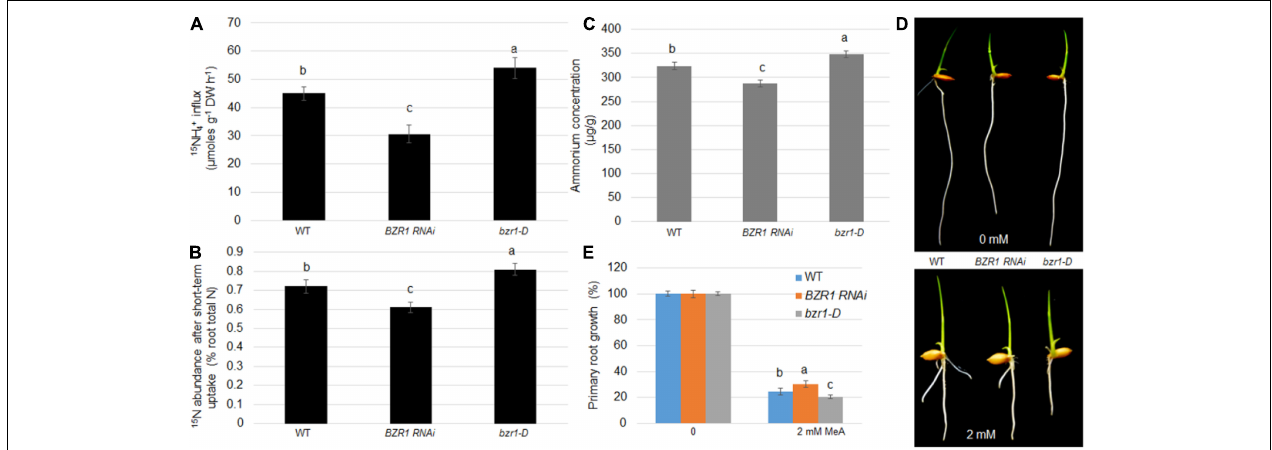
FIGURE 4 | BZR1 effects on NH 4 + uptake in plants. (A) The wild-type, BZR1 RNAi and BZR1 constitutively active bzr1-D plants were hydro-cultured in deionized water for 2 weeks, and then grown in a nitrogen-free nutrient solution for 3 days. After exposure to 200 µ M 15 N-labeled NH 4 + , the absorption of ammonium by rice roots was measured. Bars represent means ± SD ( n = 6). (B) The wild-type, BZR1 RNAi, and bzr1-D plants were hydro-cultured in deionized water for 2 weeks, and then grown in a nitrogen-free nutrient solution for 3 days. After exposure to nutrient solution containing 200 µ M 15 N-labeled NH 4 + for 6 min, the absorption of ammonium by rice roots and the 15 NH 4 + abundance in relation to the total 15 N in roots was measured. Bars represent means ± SD ( n = 6). (C) Intracellular NH 4 levels of wild-type, BZR1, and bzr1-D grown for 3 days in 0.5 × MS were detected in plant roots. Data represent means ± SE ( n = 3). (D) Under different conditions with 0 or 2 mM MeA, wild-type, BZR1 RNAi , and bzr1-D were grown in a modified 0.5 × MS medium containing 1 mM KNO 3 for 6 days. MeA treatment significantly inhibited the growth of the primary root. In the absence of MeA treatment, the BZR1 RNAi primary root was shorter than that of the wild-type and bzr1-D . After 2 mM MeA treatment, bzr1-D showed a shorter primary root than BZR1 RNAi and wild-type. (E) The primary root growth was measured from wild-type, BZR1 RNAi , and bzr1-D with or without MeA supplementation as shown in (D) . Data represent means ± SE ( n > 15 plants). The experiments were repeated at least three times. Different letters represent statistically significant differences ( P <